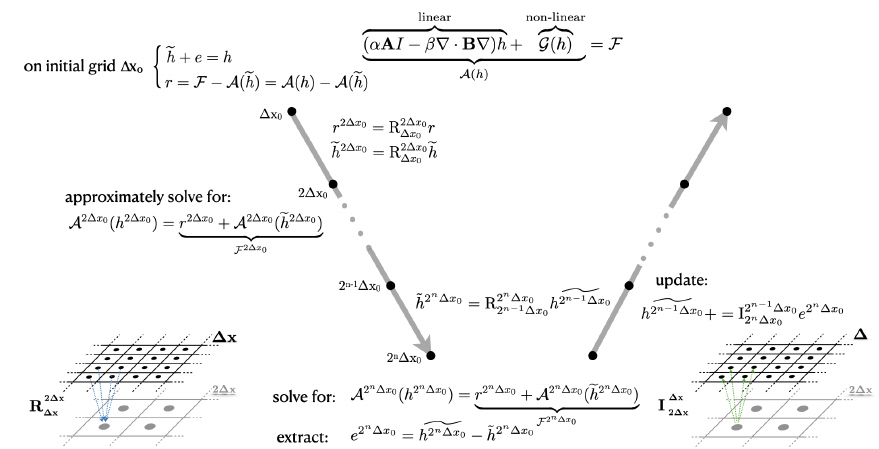
Figure 1. Illustration of one FAS MG iteration, following a V-cycle schedule of grids. See text for further explanations. (cid:94) h 2 n − 1 (cid:49)x 0 (see Fig. used to correct the local approximation